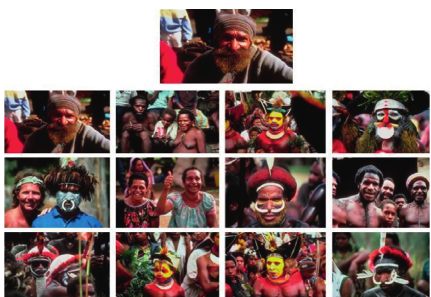
Figure 11: Retrieval of top 12 images as a result of search image selected from African category.